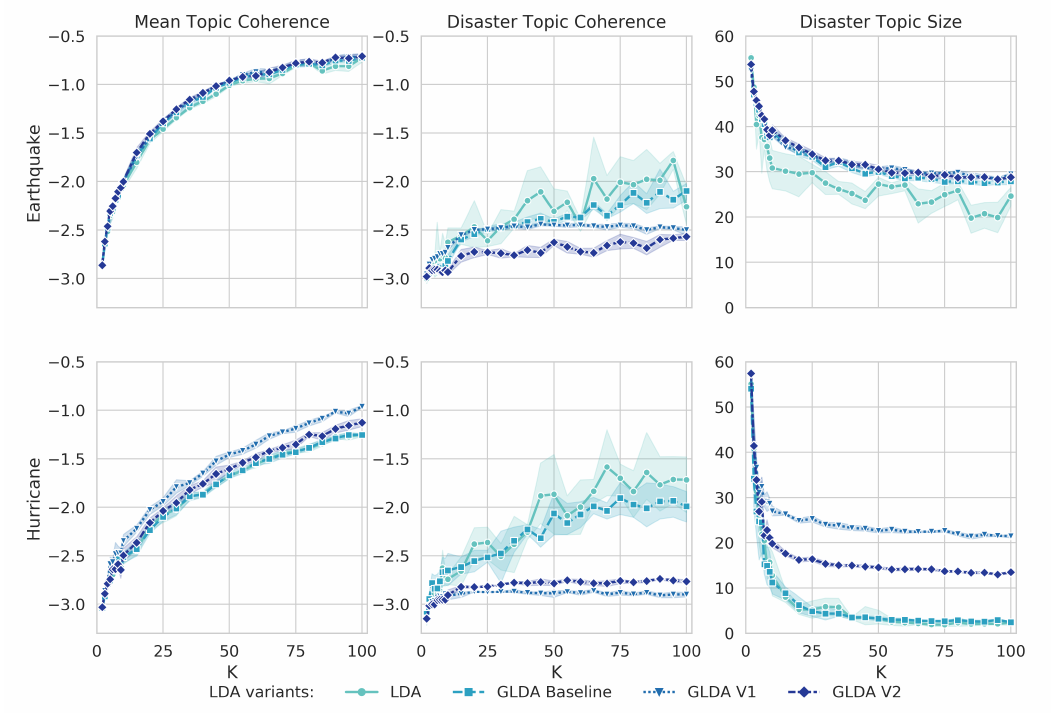
Figure 4. Average coherence over all topics ( left ), topic coherence for the disaster topic ( middle ) and the percentage of Tweets from the test set remaining in the disaster topic ( right ) for all four model variants and varying numbers of topics K . Markers indicate the mean over five runs with same K , while the upper and lower limits refer to the 95% confidence